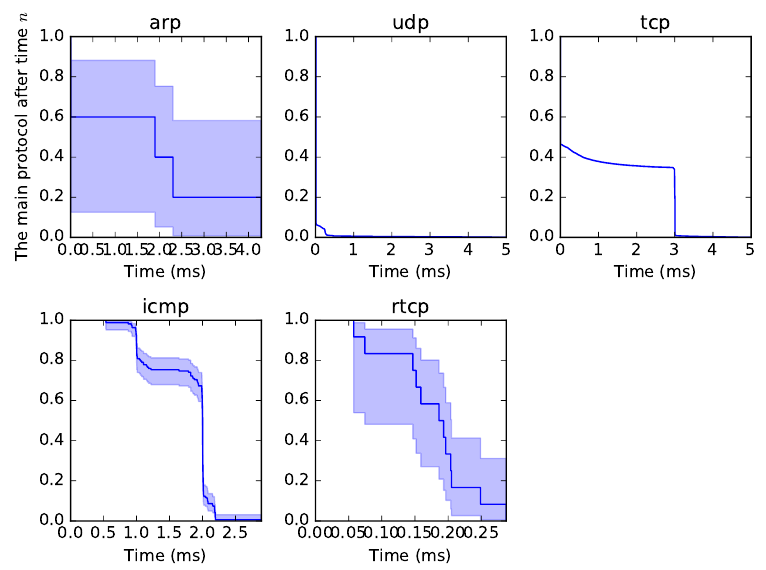
Figure 1. Survival curves of